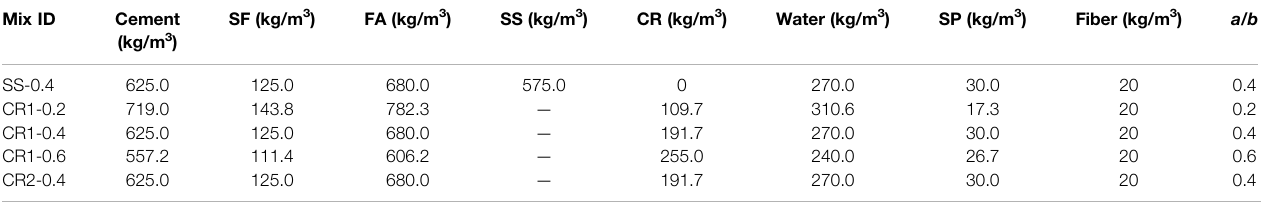
TABLE 1 | Mix proportion of HS-ECC. Mix ID Cement (kg/m 3 )